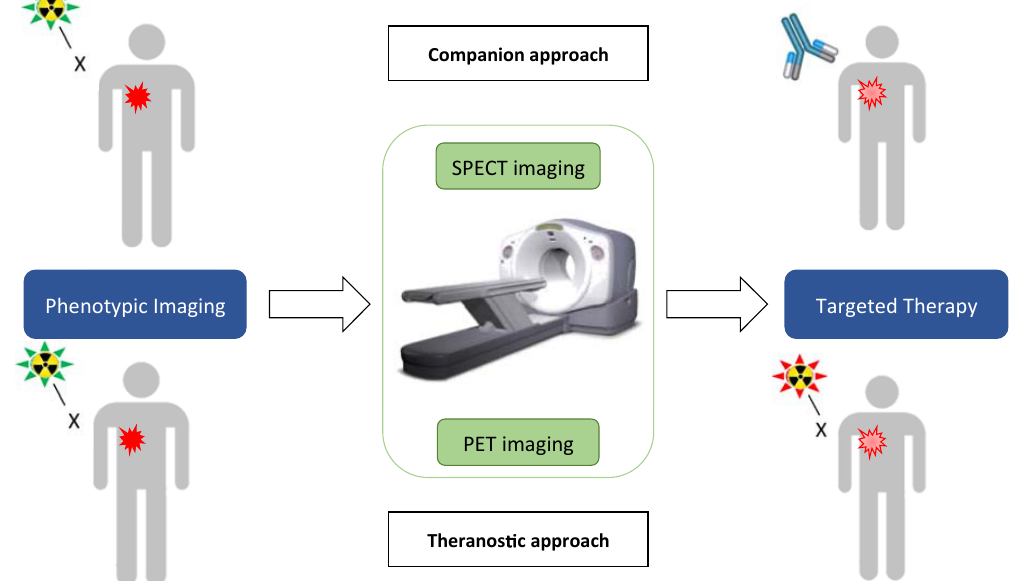
Figure 1. Companion and theranostic approaches in nuclear medicine. Phenotypic imaging ( left ) achieved using a PET- or SPECT-dedicated radiolabel compound can be followed by a non-radioactive therapy (right, top) or a radioactive therapy (right, bottom).